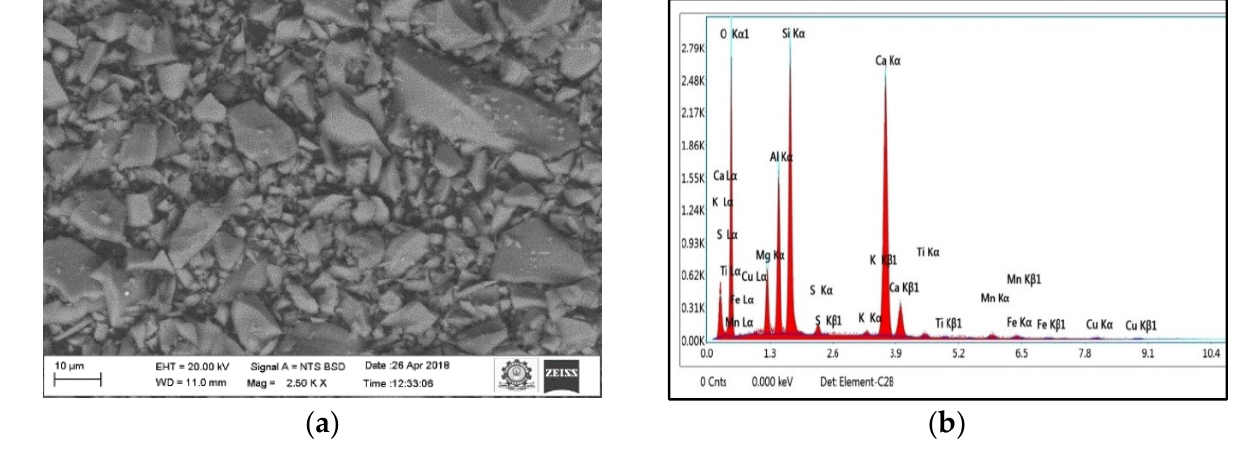
Figure 7. ( a ) SEM image of GGBS ( b ) EDAX image of GGBS.